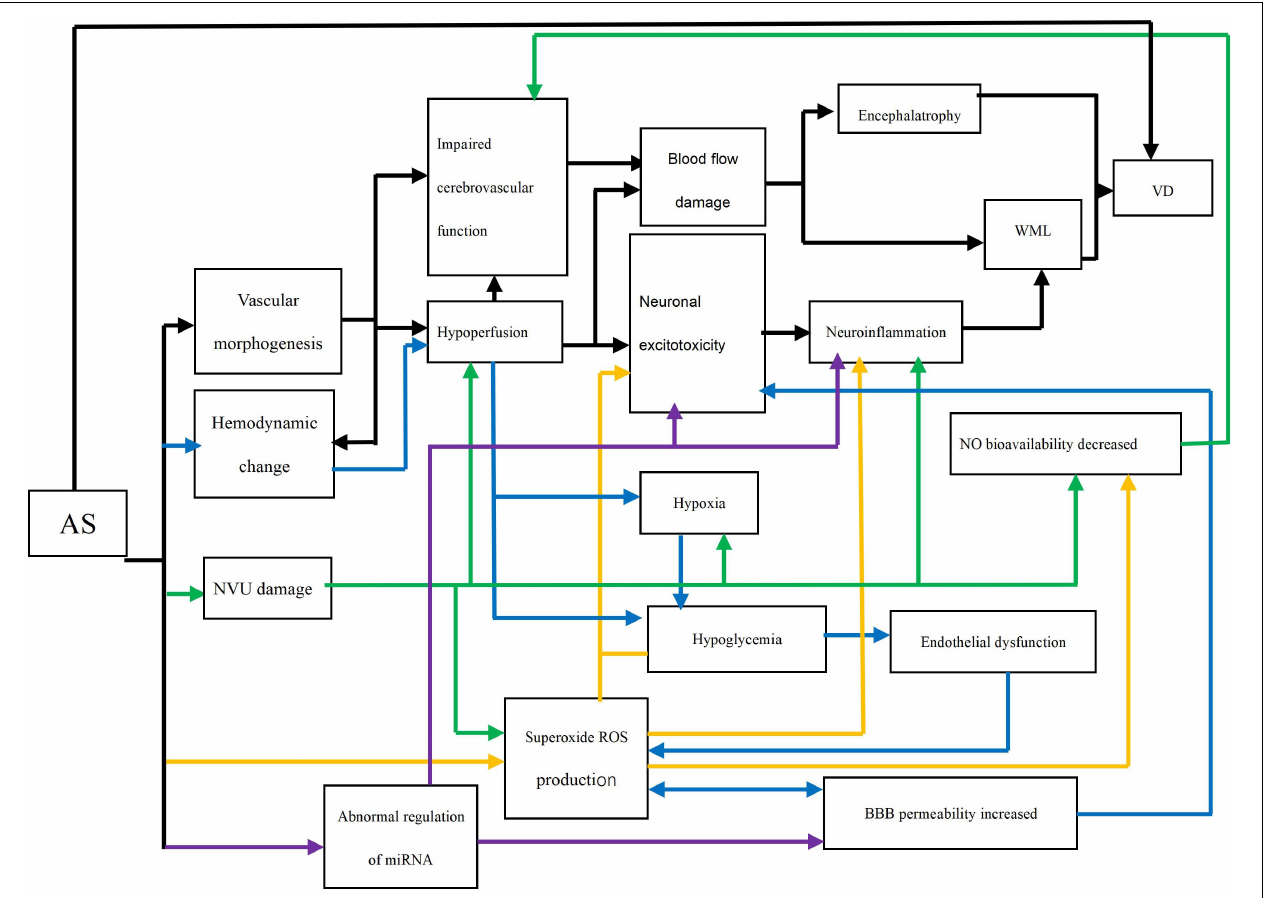
FIGURE 1 | Direct networks of AS and VD. AS: Atherosclerosis; Impaired cerebrovascular function: Endothelial relaxation and cerebrovascular automatic regulation; Neuronal excitotoxicity: Oligodendrocyte death and activation of microglia and astrocytes; WML: White matter lesion (e.g., demyelination); VD: vascular dementia; NO: Nitric oxide; ROS: Reactive oxygen species; NVU: neurovascular unit; BBB: Brain-blood barrier. Black line: The path of vascular morphogenesis; Blue line: The path of hemodynamic change; Green line: The path of NVU damage; Yellow line: The path of oxidative stress; Purple line: The path of abnormal regulation of